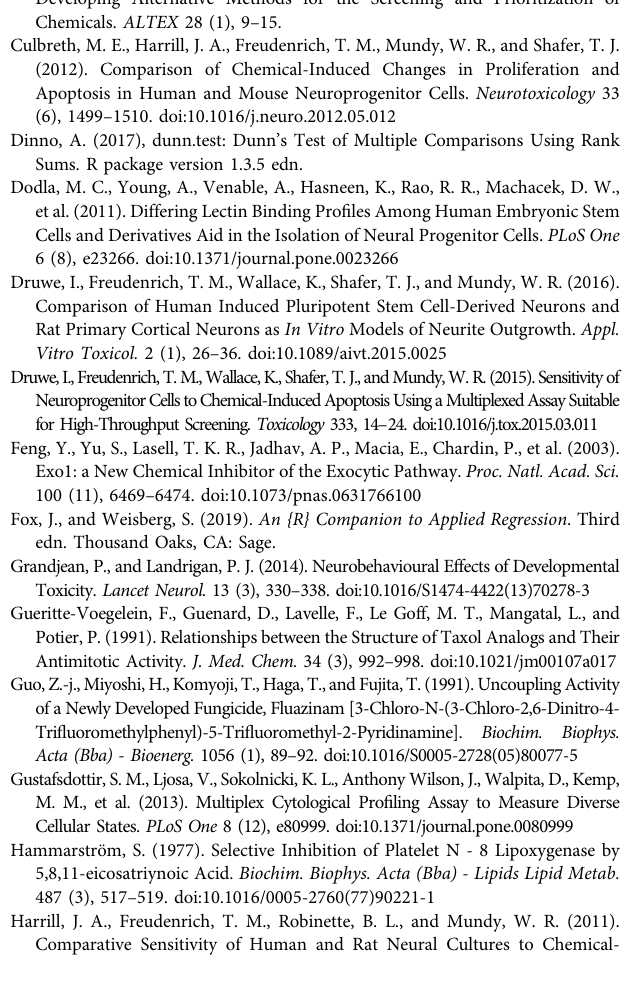
represents one biological replicate (i.e., independent culture) which includes 16 technical replicates/condition. Supplementary Figure S4 | CV concentration-response curves. Cell-level data were exported to generate cell viability concentration-response curves for each chemical in R statistical software. Data represent three biological replicates (i.e., independent cultures) which includes two technical replicates/chemical concentration per biological replicate. The enlarged symbols depict the BMC for normalized cell count or cytotoxicity (PI-positive cells). The selected reference chemicals ( Figure 7 ) are not displayed. Supplementary FigureS5 | Feature-level potency-magnitude plots.Cell-level data were exported to generate feature-level potency-magnitude plots for each chemical in R statistical software. Data represent three biological replicates (i.e., independent cultures) which includes two technical replicates/chemical concentration per biological replicate. The dotted-lines on the curves depict the global (blue), cytotoxicity (red), and normalized cell count (gray) BMC, respectively. The gray band represents the concentration-range modeled (i.e., all concentrations ≤ LOEC) in the horizontal direction and ± 1 standard deviation from the median of the DMSO vehicle control in the vertical direction. Selected reference chemicals ( Figure 7 ) are not displayed. Supplementary Figure S6 | Global concentration-response curves. Cell-level data were exported to generate global concentration-response curves for each chemical in R statistical software. Data represent three biological replicates (i.e., independent cultures) which includes two technical replicates/chemical concentration per biological replicate. The enlarged symbols depict the BMC for phenotypic pro fi ling (see Table 2 ). Selected reference chemicals ( Figure 7 ) are not